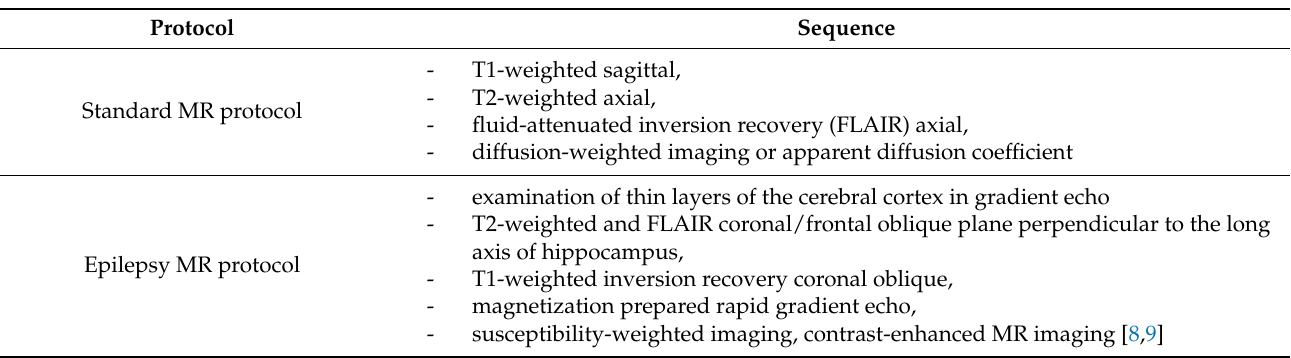
Table 1. Difference between standard and epilepsy MR